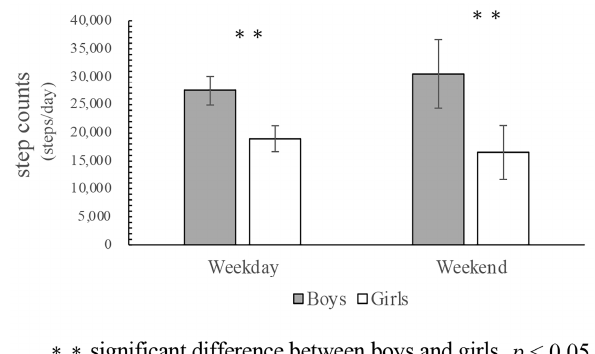
Figure 2. Step counts with gender